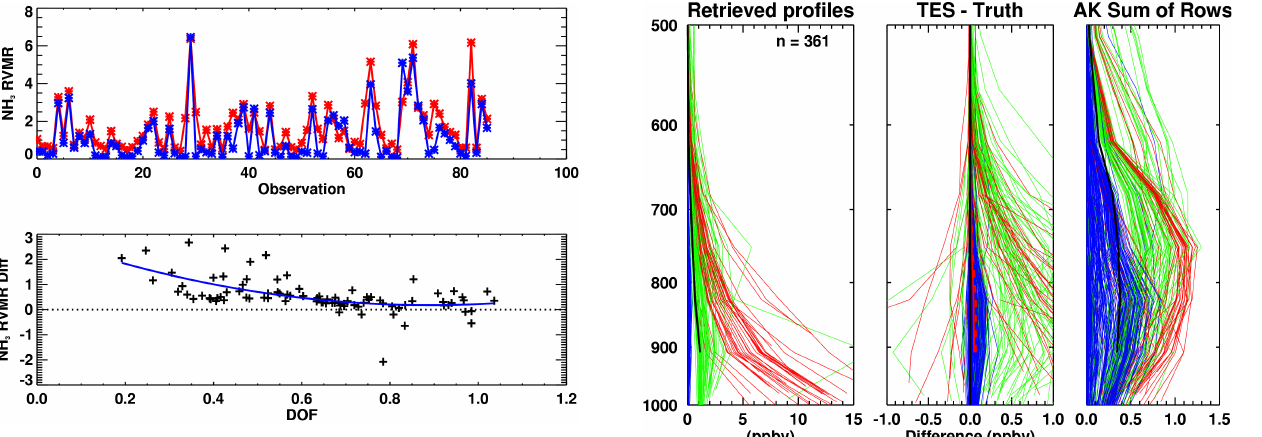
Fig. 10. Simulated retrieval results: (left) retrieved profiles, (mid- dle) retrieved – true profiles, where the thick solid red line is mean difference and the dashed red line is standard deviation (the black line is just the reference zero line), (right) sum of the rows of the av- eraging kernel (black line is the average). The thin colors indicate type of true profile: polluted (red), moderate (green), unpolluted